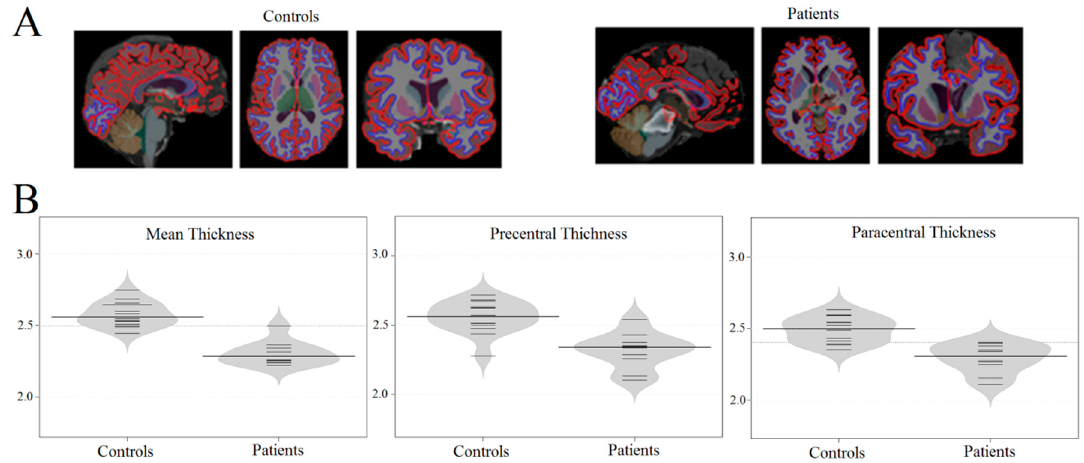
Figure 1. The morphometry results obtained by Freesurfer. A : examples of individual morphometry (for patients and healthy participants) showing the di ff erence in the cortical thickness between comatose patients and the control group. B : Bean plots of cortical thickness for three measurements: mean cortical thickness, thickness of paracentral area, and precentral area (small black whiskers—individual values of cortical thickness).